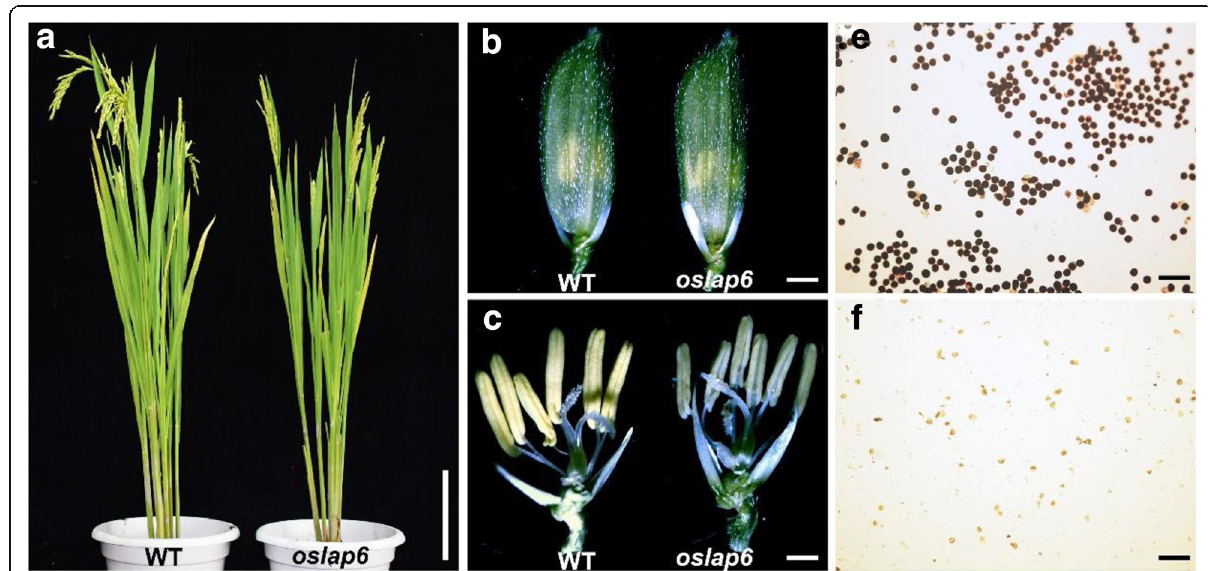
Fig. 1 Phenotype of the WT and oslap6. a The WT and oslap6 after heading. b Spikelets of the WT and oslap6 . c Spikelets of the WT and oslap6 in ( b ) with the palea and lemma removed. d and e Pollen grains of the WT and oslap6 with I 2 -KI staining, respectively. Scale bars=20 cm ( a) ; 2 mm ( b ); 1 mm ( c ); 150 μ m ( d and e